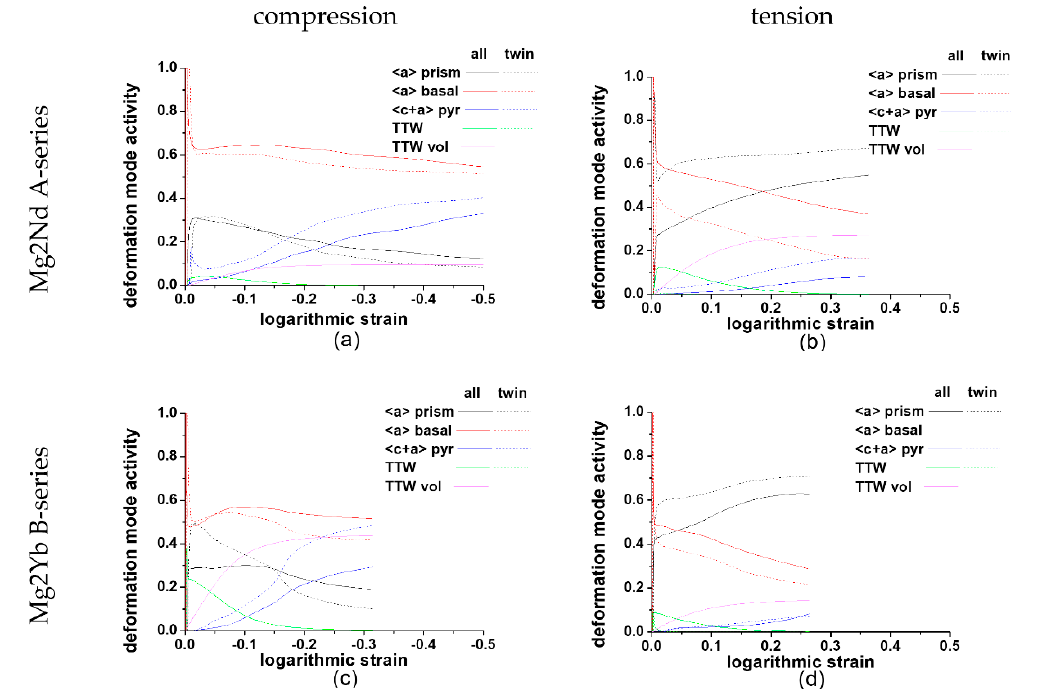
Figure 6. Deformation mode activity as a function of strain of the Mg2Nd A-series during ( a ) compression and ( b ) tensile tests and the Mg2Yb B-series during ( c ) compression and ( d ) tensile tests.